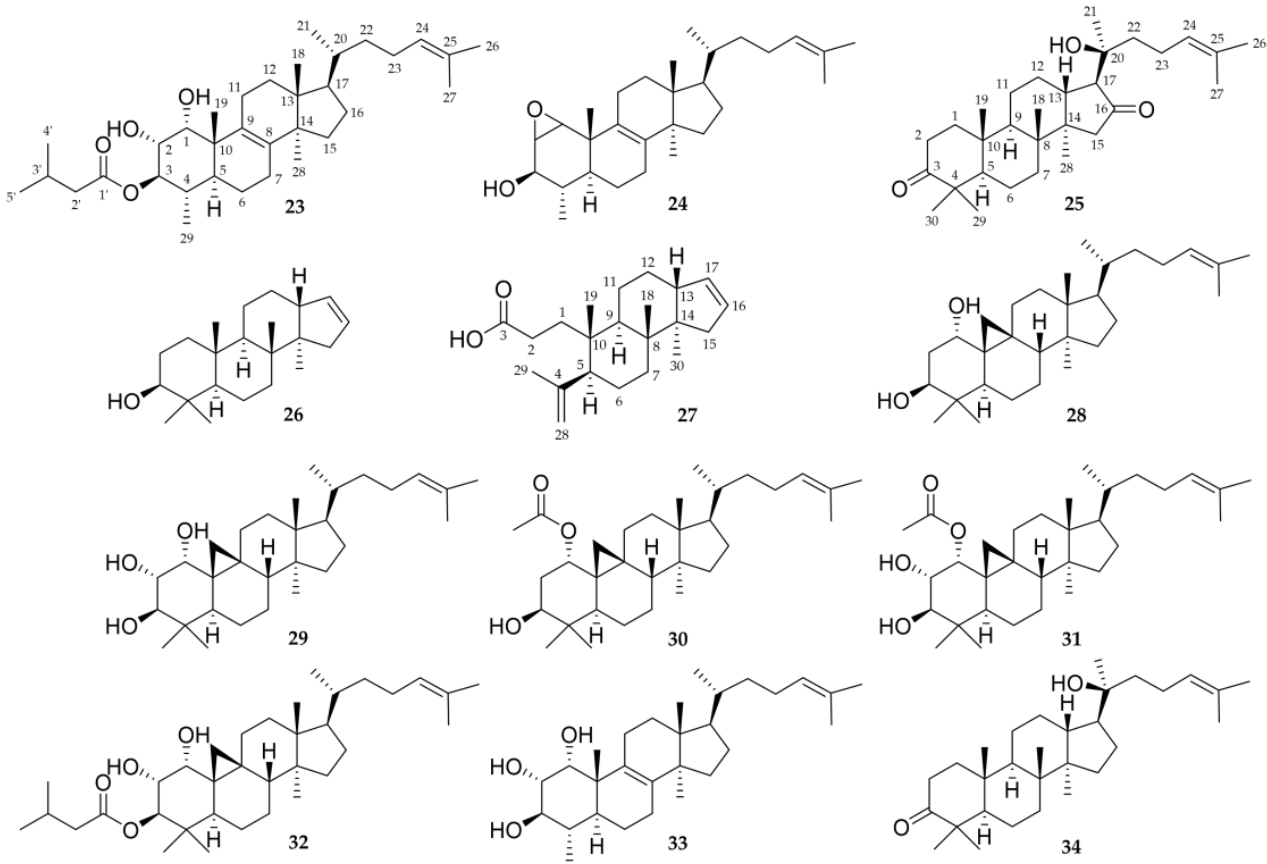
Figure 9. Chemical structures of isolated triterpenoids ( 23 - 34 ).